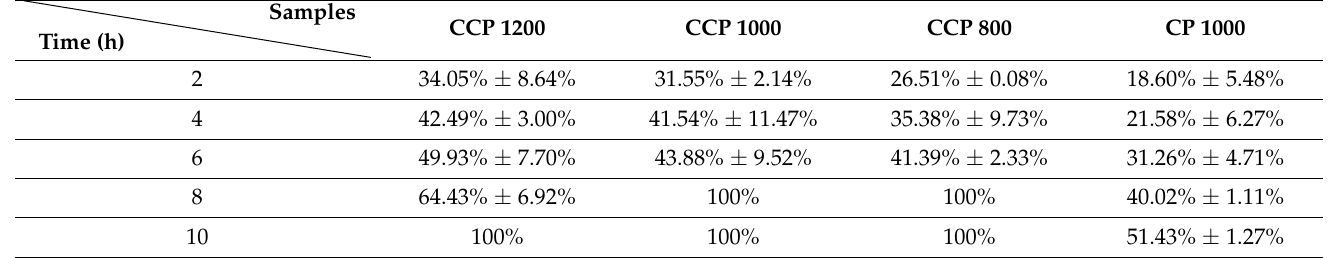
Figure 6. ( a ) Weight loss curve of printed scaffold in accelerated acidic degradation experiment; ( b ) degradation process of CCP 1000 scaffolds. Table 1. Weight loss results of printed scaffold in accelerated acidic degradation experiment.